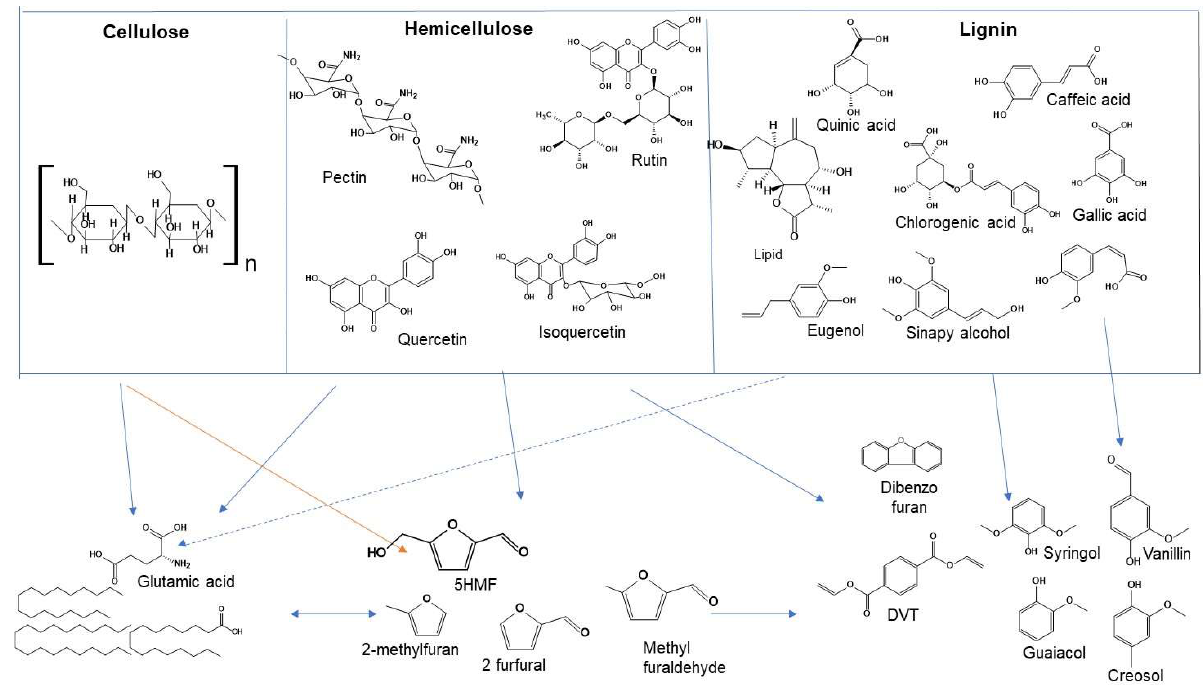
Figure 4. Proposed TPB components transformation model producing chemicals as identified in HTC-PL.